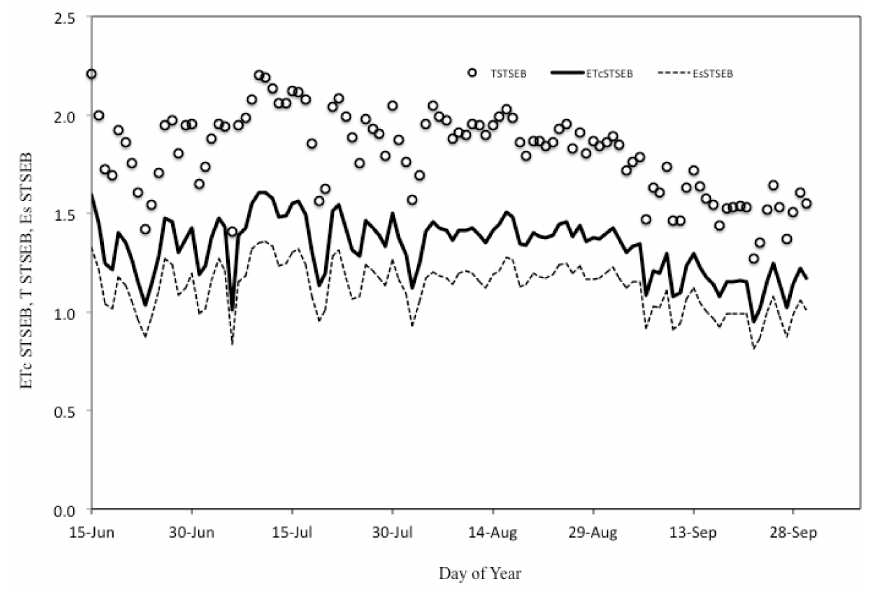
Figure 5. Crop evapotranspiration ( ET cSTSEB ), transpiration ( T STSEB ), and soil evaporation ( E sSTSEB ) modeled with STSEB for